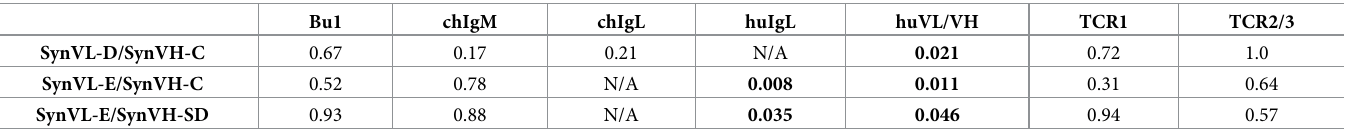
Table 1. Student’s T-test, OmniChickens versus wild-type birds. Bu1 chIgM chIgL huIgL